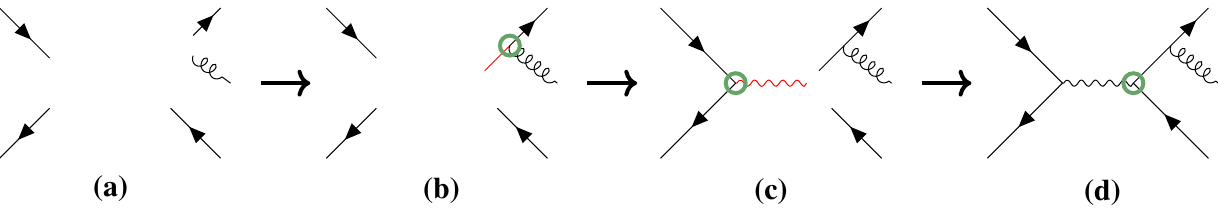
Fig. 2 Iterative steps used to evaluate a given Feynman diagram in the helicity amplitude formalism. In a the spinors of the external parti- cles are evaluated. In b and c the algorithm works through each vertex